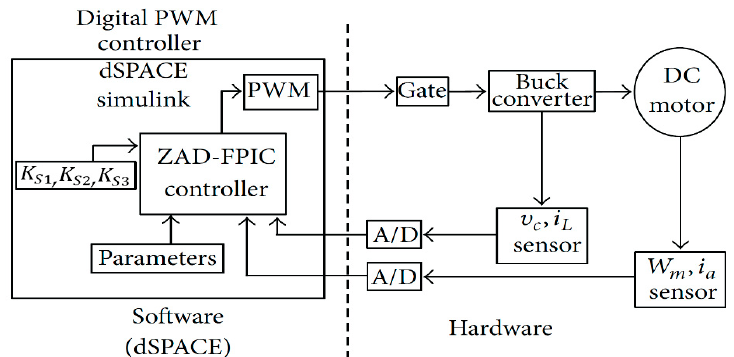
Figure 1. Buck converter connected to an electric DC motor and controlled by zero average dynamics-fixed-point induced control (ZAD-FPIC).